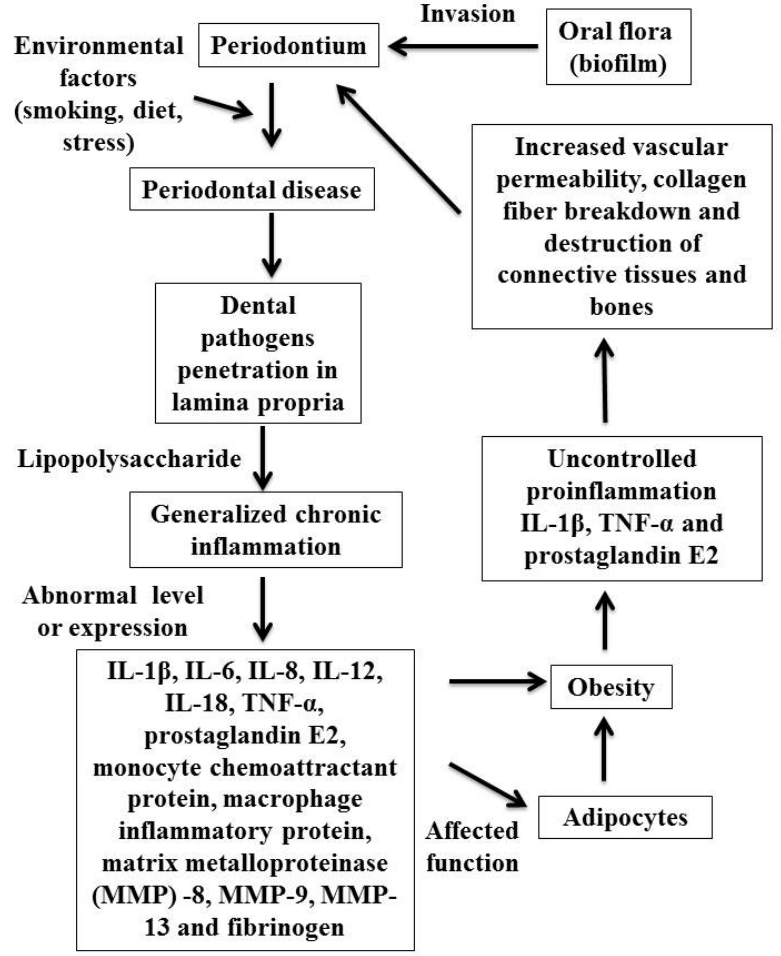
Figure 2. Probable connections between periodontal diseases and obesity.